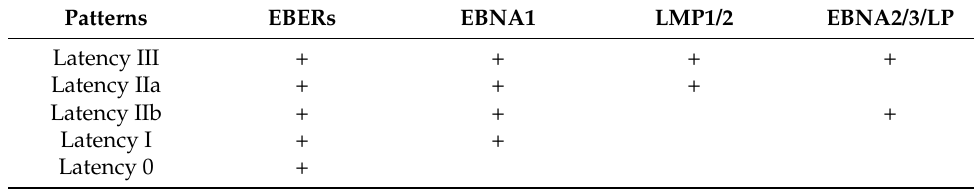
Table 2. EBV latency